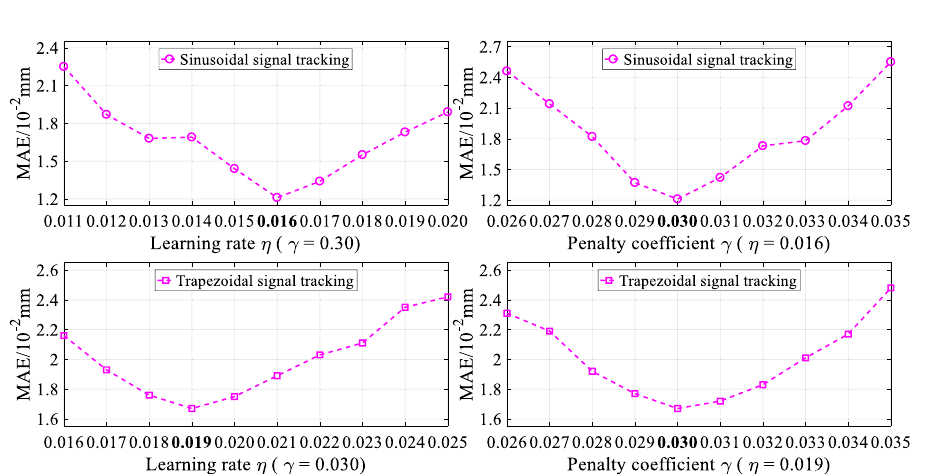
Figure 10. Experiment results of the RNN-based hybrid controller under different hyper-parameters.